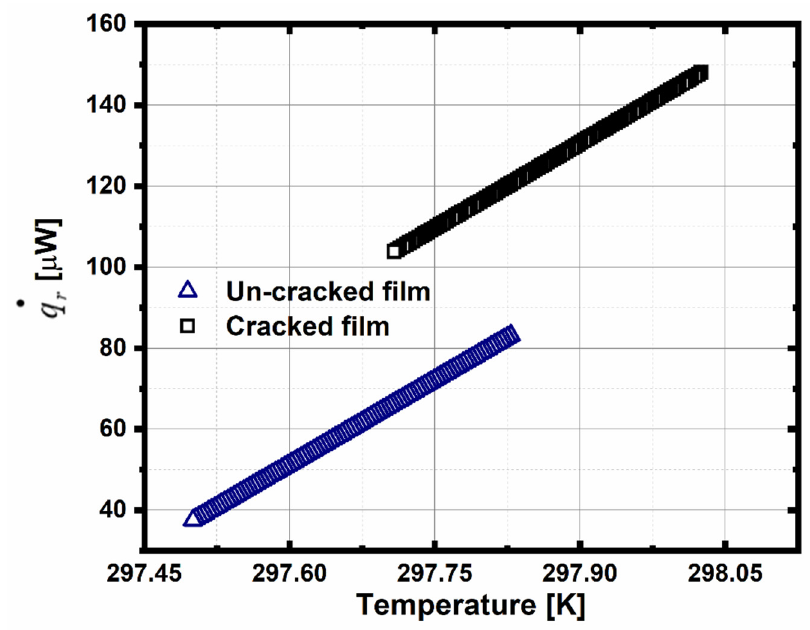
. q r as a function of